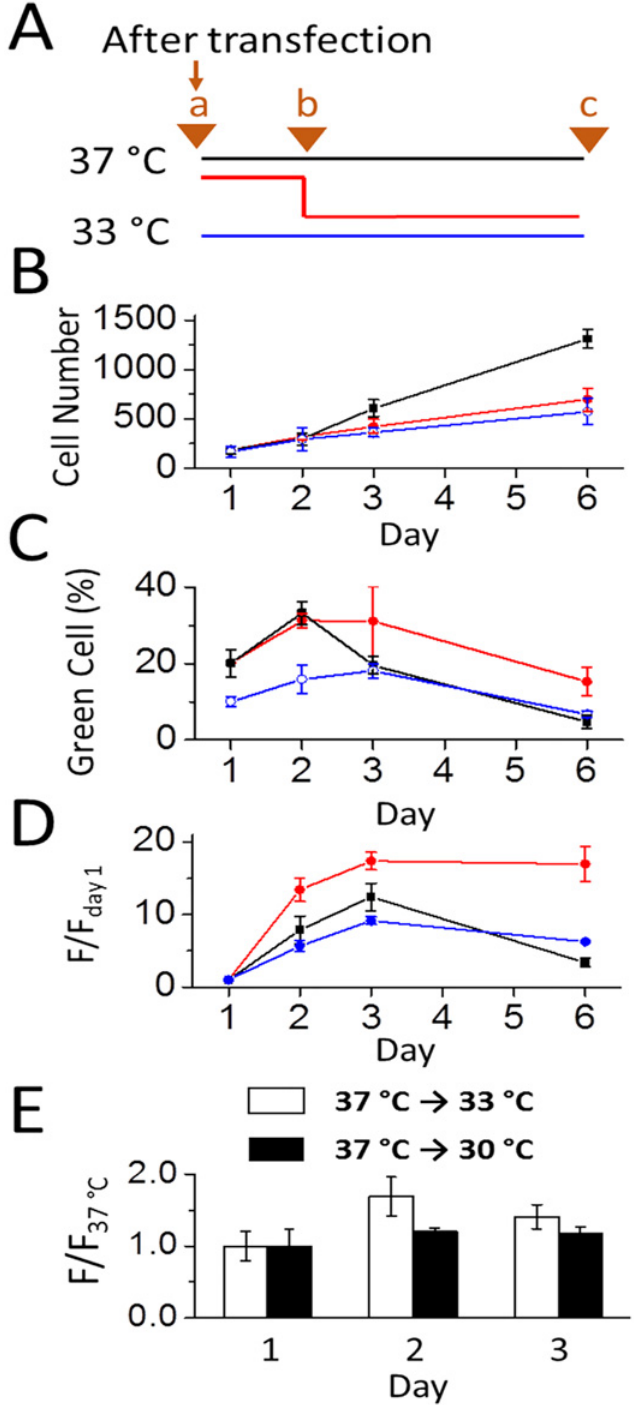
Fig 5. Time course of GFP expression in HEK-293S cells at 30°C, 33°C and 37°C. (A) Point ‘ a ’ represents the 5 th hour after transfection at which the medium was replaced (all the data were collected from cells transfected with 2 μ g GFP plasmid/35 mm dish using calcium phosphate). Three sets of experiments began as reflected by three color-coded lines as in panels A-D, and in each set, triplicate dishes were used in our experiments. Specifically, blue line represents maintaining a culture at a 33°C incubator. Red line refers to the culture that first stayed at a 37°C incubator overnight (or 19 hours precisely) and then transferred to the 33°C